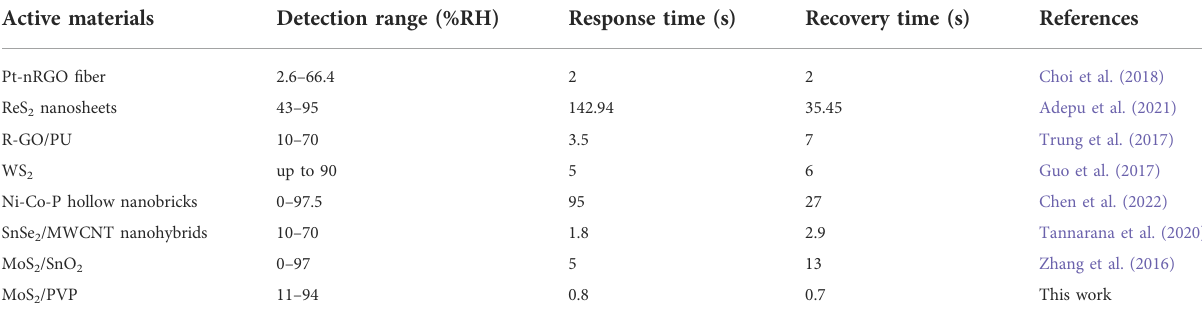
TABLE 1 Sensing performances of humidity sensors for respiration monitoring in